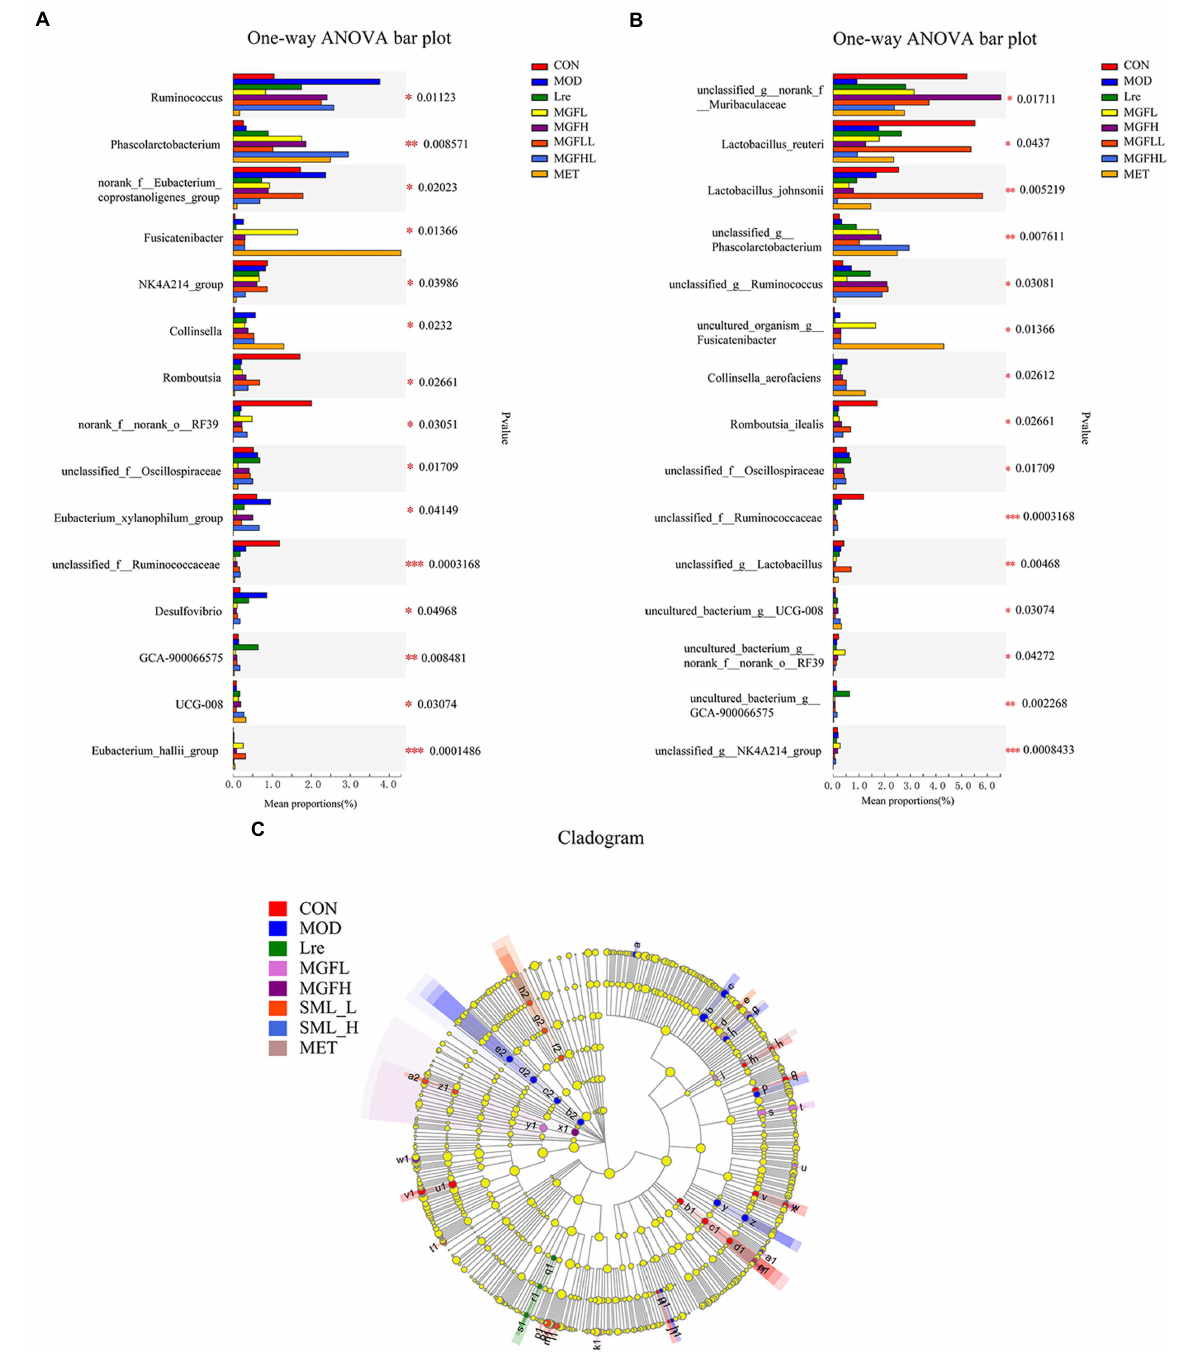
FIGURE 5 Analysis of intestinal microbiome differences. (A,B) were the analysis results of the differences between groups at the genus and species levels. (C) represented the LEfSe analysis (the circle of evolutionary branching from internal to external radiation represented the classification level from phylum to species), and different color nodes represented microbial groups that were significantly enriched in corresponding groups and had a significant influence on the differences between groups. The yellowy nodes indicated the microbial groups that had no significant difference among different